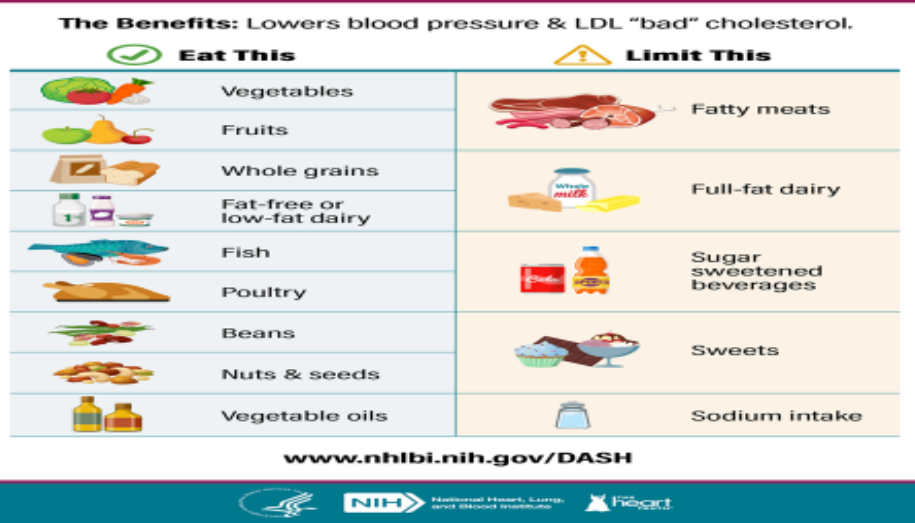
Figure 1. Eating plan in the DASH diet showing foods that should be consumed either in excess or under limits (Adapted from [13], www.nhlbi.nih ‐ gov/DASH).